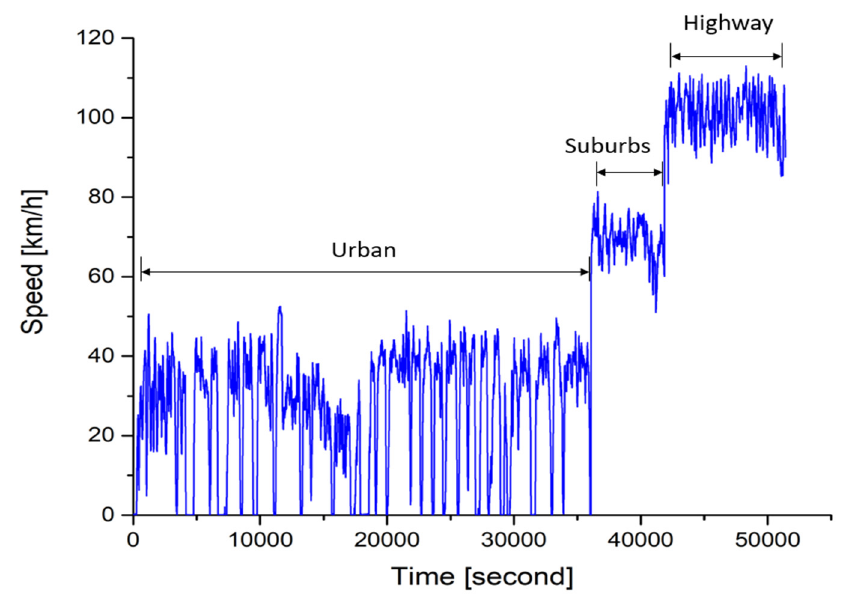
Figure 3. Speed variations of testing vehicle in route 1 of the real road.